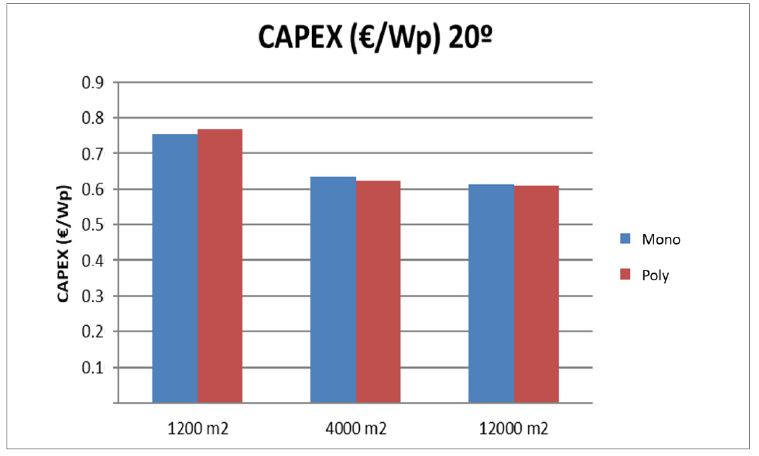
Figure 10. Normalized CAPEX for installations with a 20° tilt.